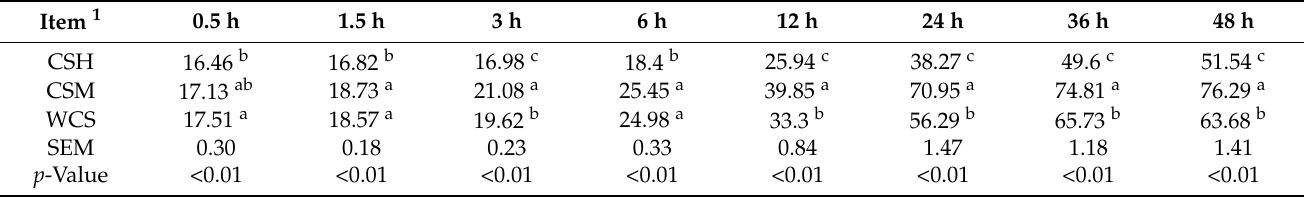
Table 4. Ammonia N concentration of cottonseed and its by-products by in vitro fermentation